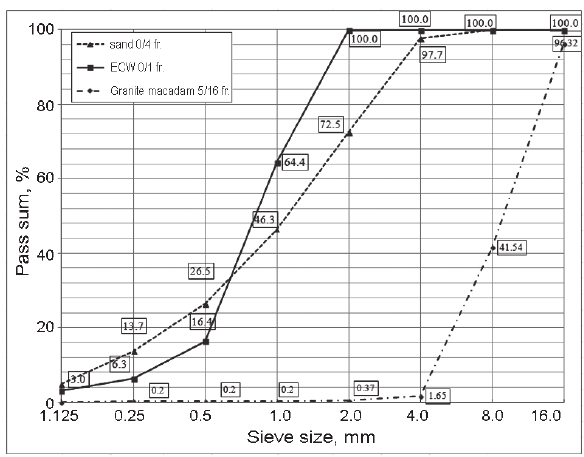
Fig. 1. sieve analysis data of sand, granite macadam and